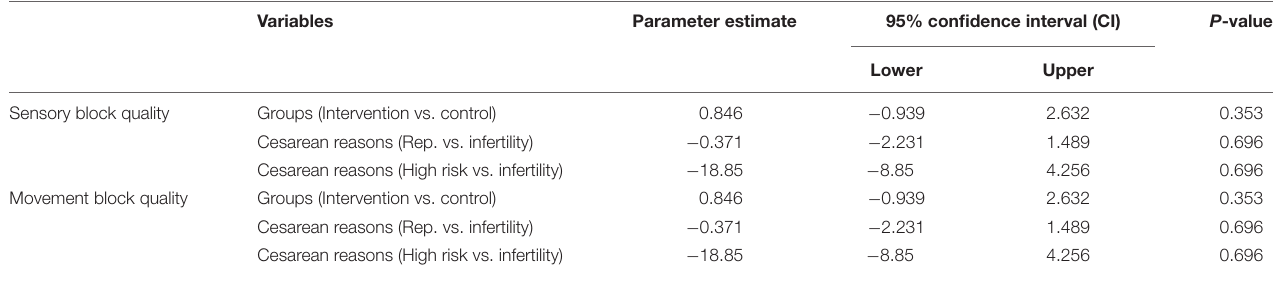
TABLE 6 | The results of ordinal regressions for sensory and movement block quality.